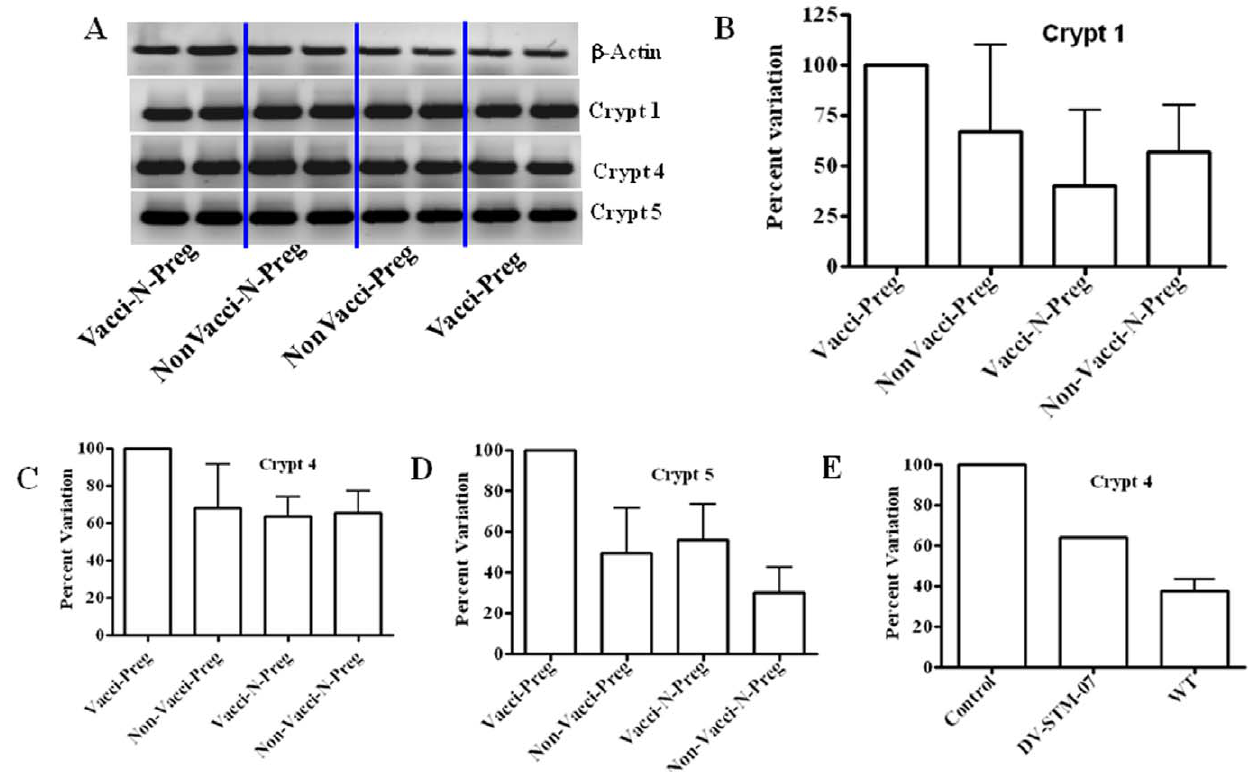
Figure 1. Expression level of Cryptdine in intestine of vaccinated mice is not altered. RT-PCR showing expression level of Cryptdine in intestine of vaccinated; pregnant (Vacci-preg), non-pregnant (Vacci-N-preg) and non-vaccinated; pregnant (NonVacci-preg), non-pregnant (NonVacci- N-preg) mice (A). From each group of mice (Explained in material and methods) intestine was isolated and the RNA isolated using Trizol (SIGMA). RT- PCR was done and densitometric analysis for the expression levels of Cryptdine 1 (B), Cryptdine 4 (C and E) and Cryptdine 5 (D) as against b -actin used as internal control. Data shows that the various cryptdine levels are not down regulated after infection with DV-STM-07 and are similar to control. doi:10.1371/journal.pone.0009139.g001 PLoS ONE |